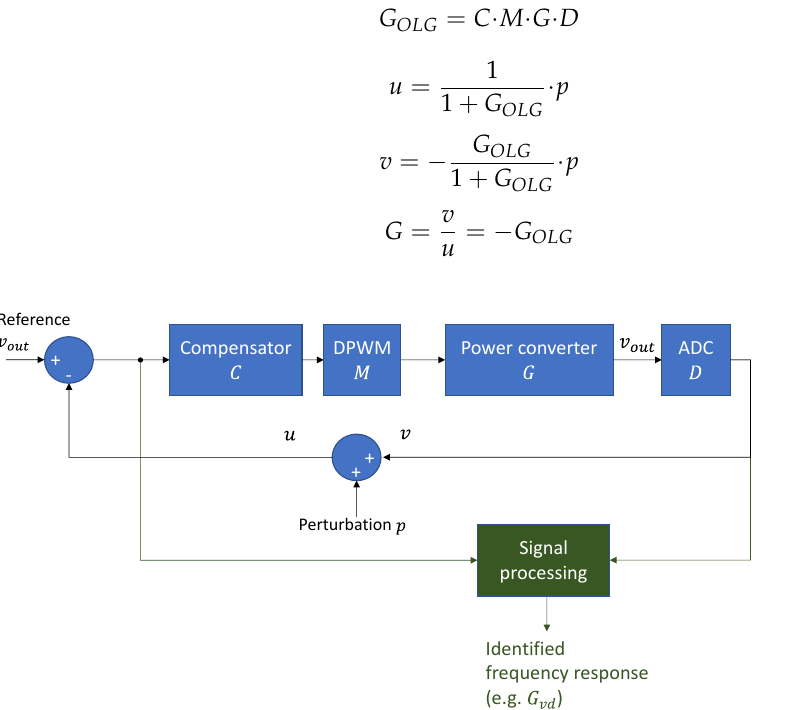
Figure 4. Block diagram of a power converter working closed-loop and injecting a perturbation 𝑝 .